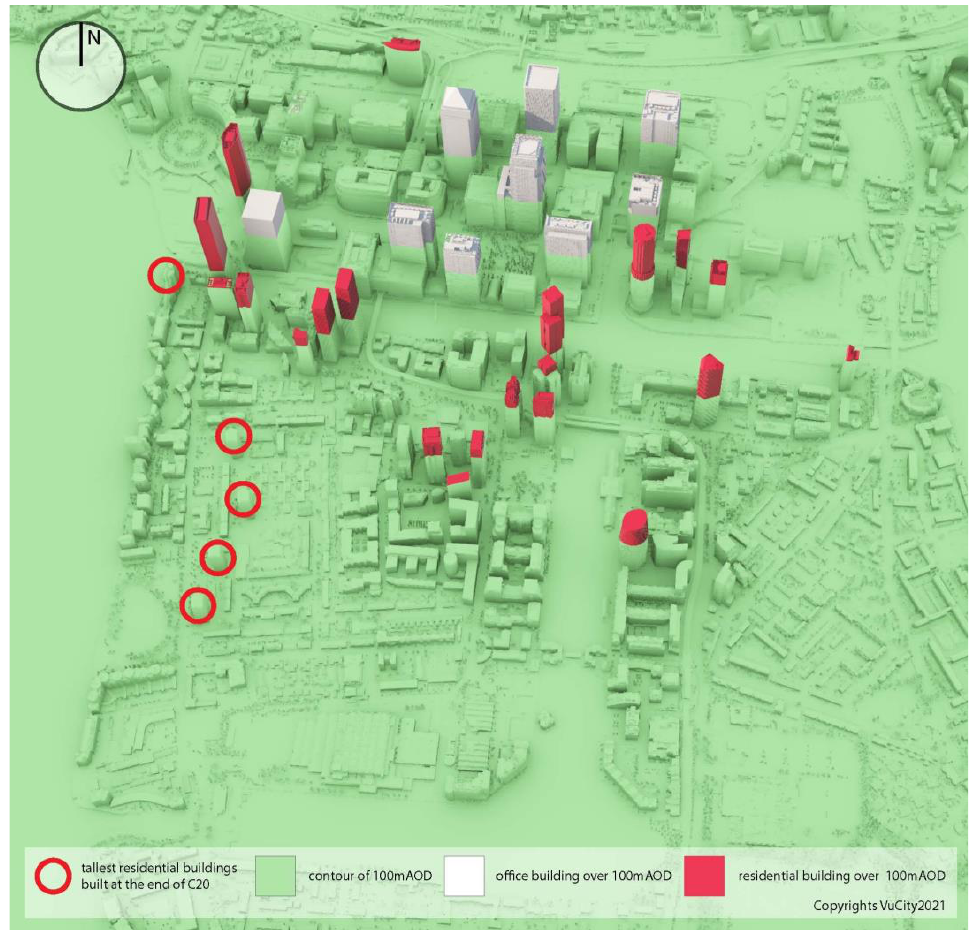
Figure 2. Research sample: Completed buildings taller than 100 AOD in the Canary Wharf area, London, UK. Source: VuCity 2021, created by